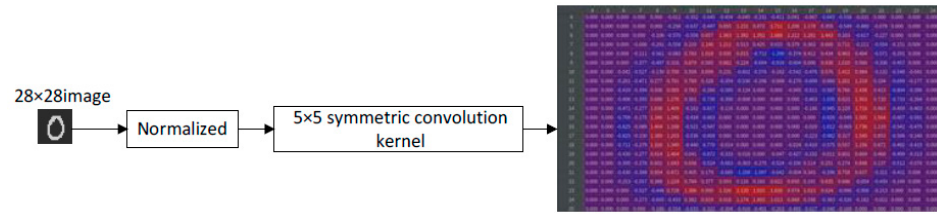
Figure 2. Blur Processing.